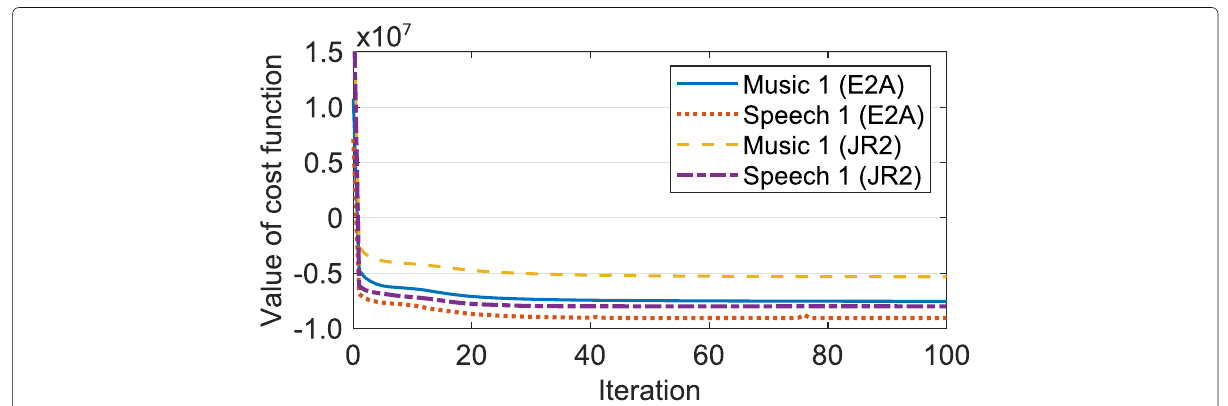
Fig. 5 Values of negative log-likelihood function (18) of Consistent ILRMA+BP (window length, 256 ms; shift length, 32